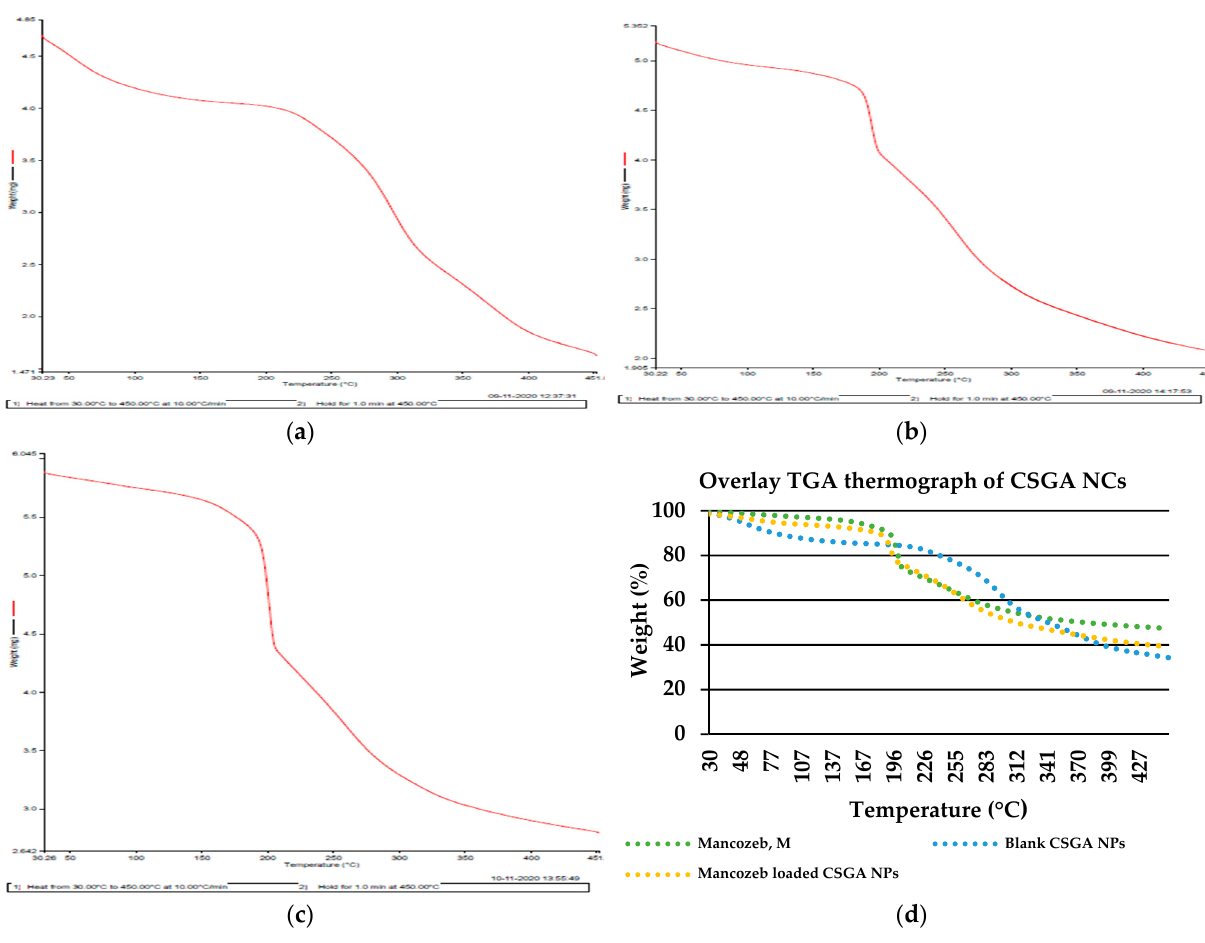
Figure 4. Thermogravimetric (TGA) thermograms of ( a ) CSGA blank NCs; ( b ) CSGA-M-1.0 NCs; ( c ) commercial mancozeb; in the form of weight, in mg; ( d ) overlay TGA thermograph in the form of weight %.